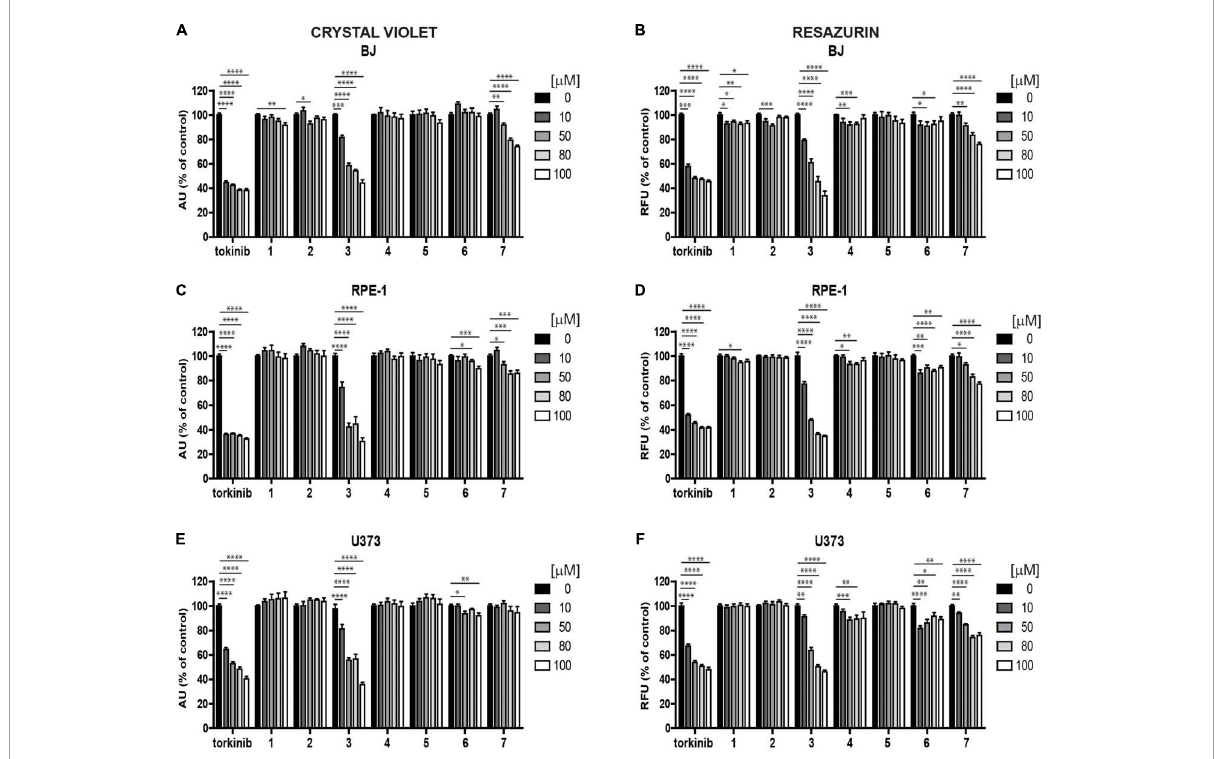
FIGURE4 Screening of new compounds on proliferation of normal and cancerous cells. Normal human dermal fibroblasts BJ (A,B) , human immortalized retinal pigment epithelium RPE-1 (C,D) , and human glioblastoma U373 (E,F) cells were exposed to compounds 1 – 7 in the concentration range of 0–100 µ M for 24 h and assayed by crystal violet (A,C,E) and resazurin (B,D,F) assays. Torkinib served as a reference compound. The experiment was done in triplicate. Data were normalized to untreated cells and plotted as mean ± SEM. Two-tailed Student’s t -test, ∗∗∗∗ p < 0.0001; ∗∗∗ p < 0.001; ∗∗ p < 0.01; ∗ p <